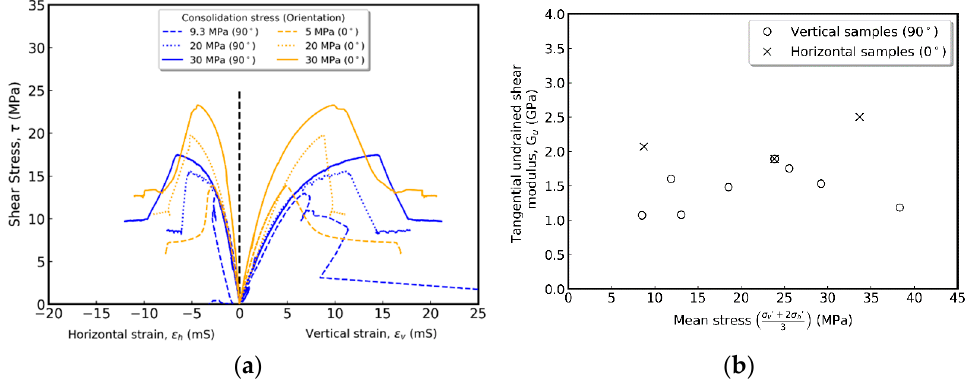
Figure 7. ( a ) Vertical and horizontal strains versus shear stress from tests on samples oriented perpendicular to layering ( blue ) and parallel with layering ( orange ). ( b ) Tangential undrained shear moduli.